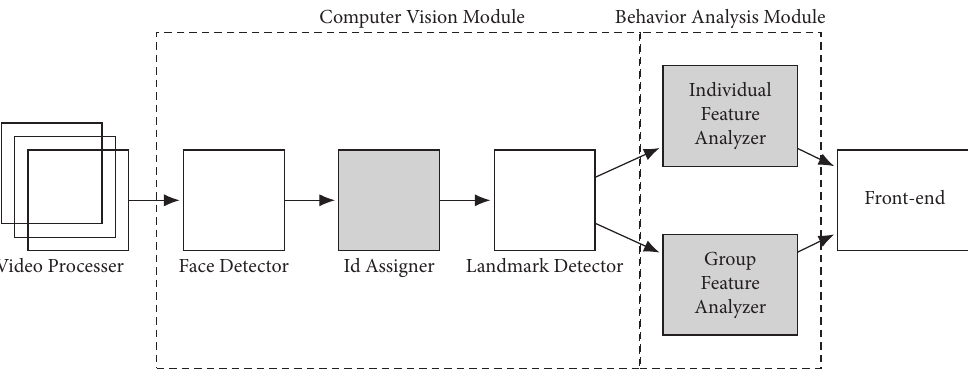
Figure 2: Data processing pipeline of